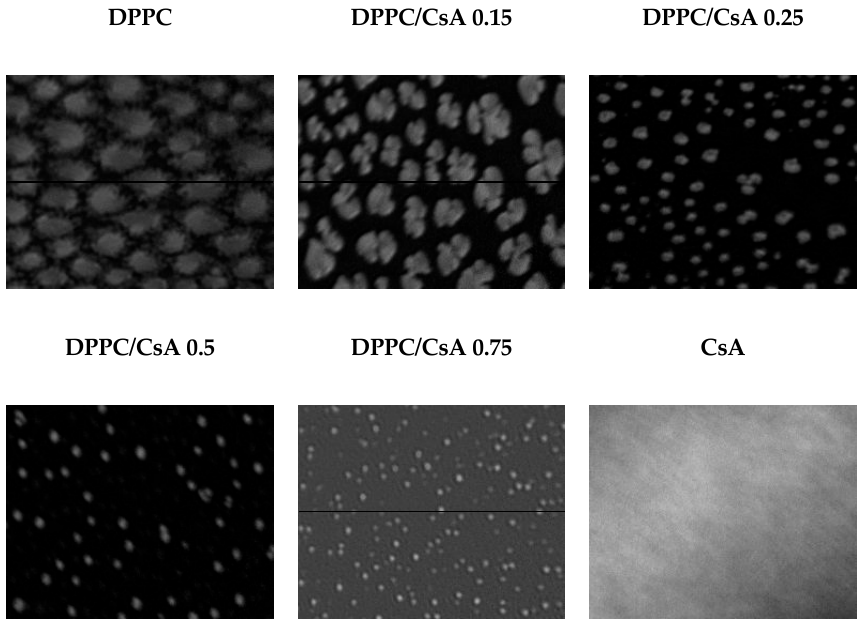
Figure 2. Brewster angle microscopy (BAM) images of the mixed monolayers on the water subphase at 10 mN/m (0.15; 0.25; 0.50; and 0.75 indicate the molar fractions of CsA).